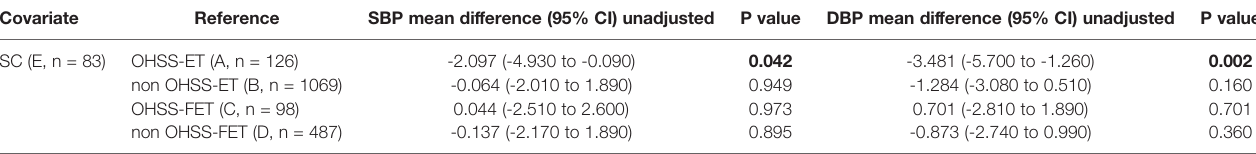
TABLE 4 | Comparison the BP of SC (group E) and ART group. Covariate